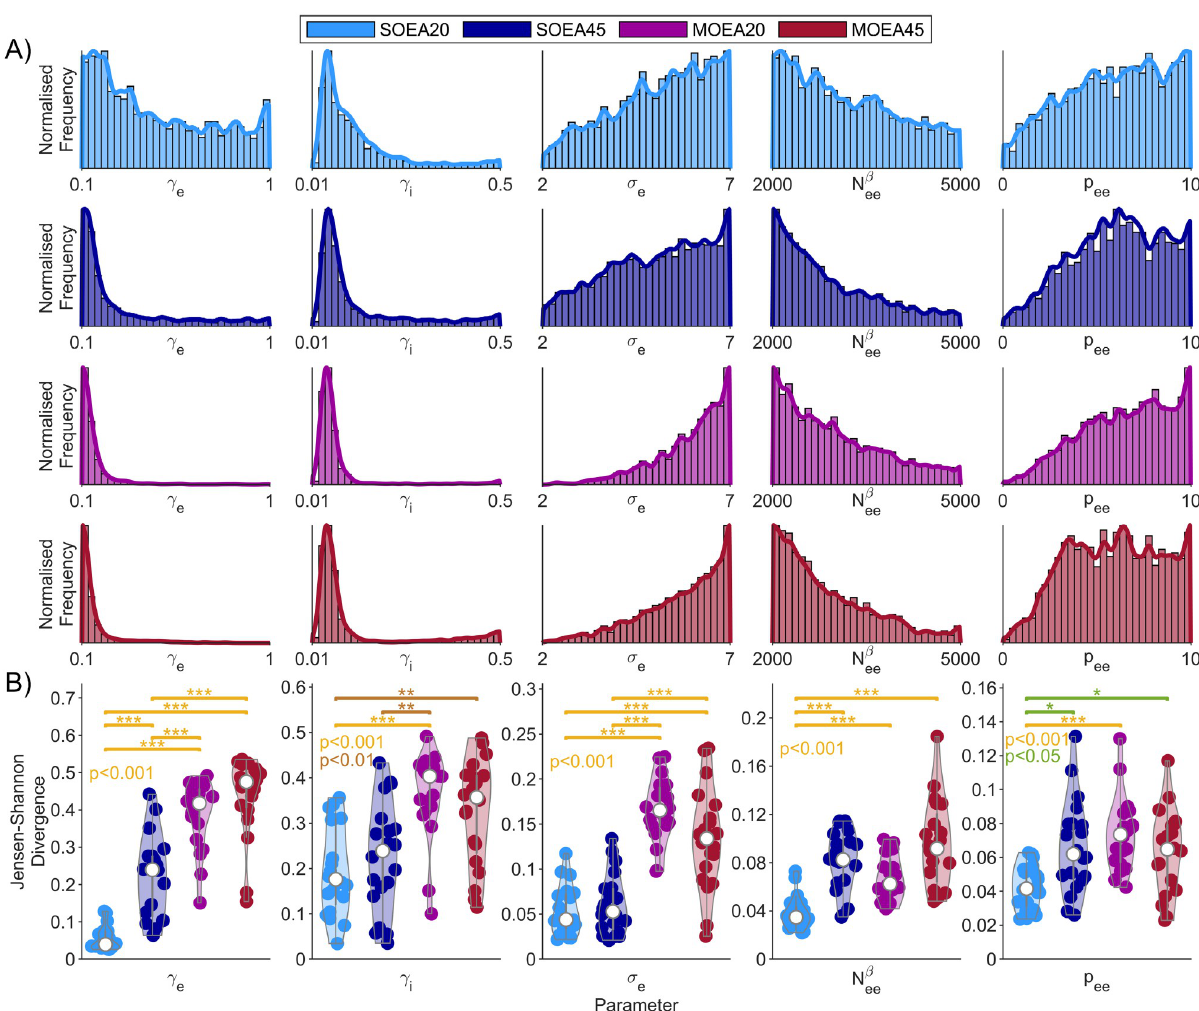
Fig 7. Parameter distributions recovered from all control data sets. A) shows the distributions of 5 of the parameters that were recovered from 100 repeats of each algorithm on all subjects (coloured as per the legend). These 5 parameters represent the biggest deviation from a uniform distribution in at least one of the algorithms (see Methods). The parameter bounds in these plots are set to those used in the optimisation (see Table 1). B) shows the JSD of the marginal distributions, when compared to a uniform distribution. These are shown as violin plots over subjects. P-values were obtained from a Mann-Whitney U test, with Bonferroni